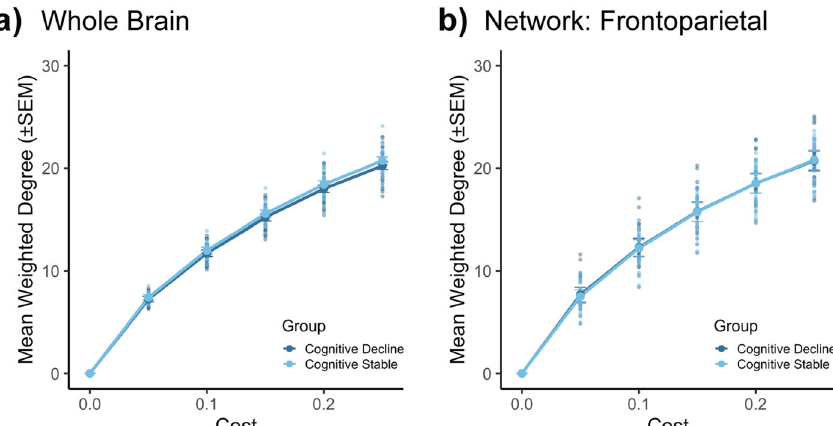
Fig. 3 Weighted-degree analyses. Mean (±SEM) weighted degree ( ‘ strength ’ ) of ( a ) all 300 nodes and of ( b ) nodes within the frontoparietal network, speci fi cally. Weighted degree ( a, b ) was derived from thresholded matrices. There were no signi fi cant differences across groups (all p -values > 0.21). Comparisons reported here are between n = 37 cognitively declining individuals and n = 22 cognitively stable individuals. See Supplementary Tables 9 and 10 for complete summaries